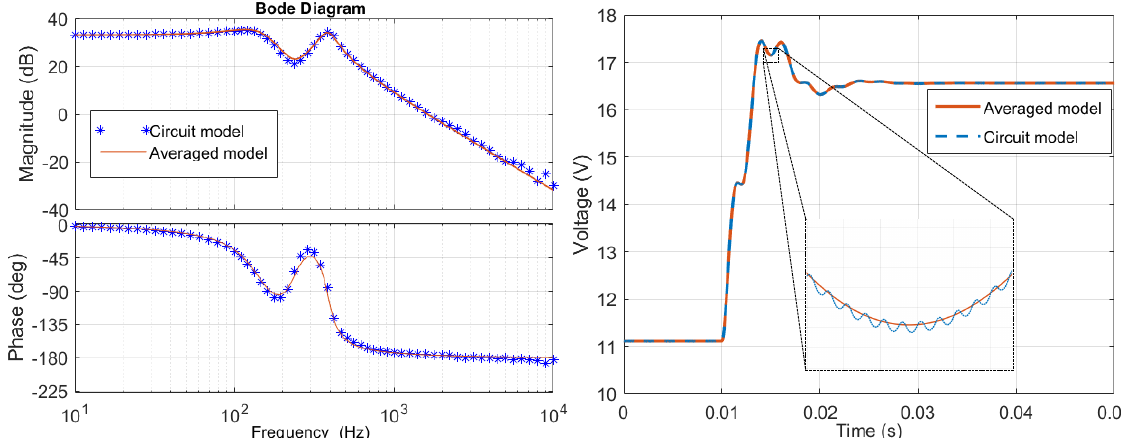
Figure 5. Bode plot and step response of Sepic/Zeta converter